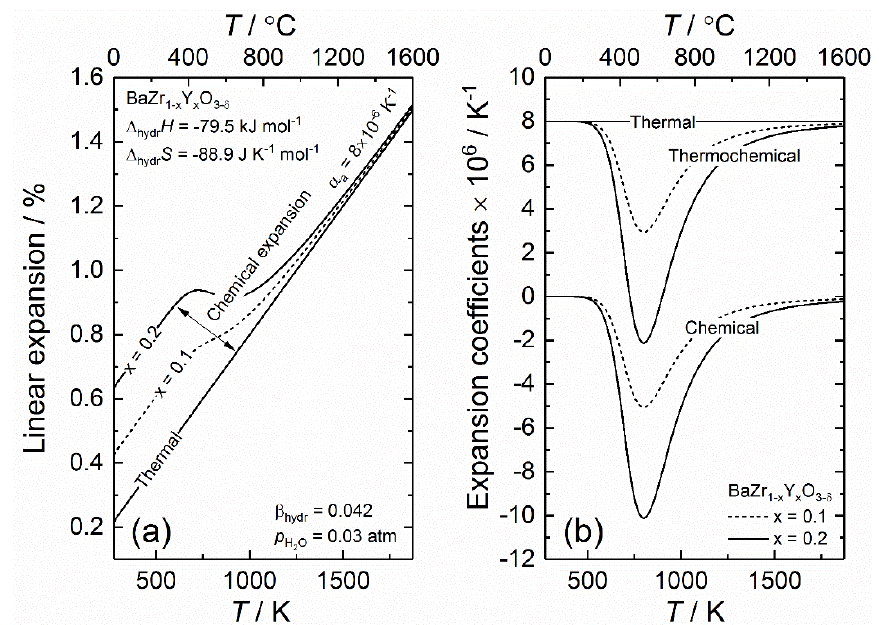
Figure 1. Linear expansion of BaZr 1 − x Y x O 3 −δ (BZY) as a function of temperature under humid conditions ( p H = 0.03 atm) for 10–20 mol% yttrium and β hydr = 0.042 in ( a ) and the corresponding thermal, chemical and thermochemical expansion coefficients in ( b ). The expansion of BZY under dry conditions (no chemical expansion) is given for reference. The linear thermal expansion coefficient is consistently 8 × 10 − 6 K − 1 .